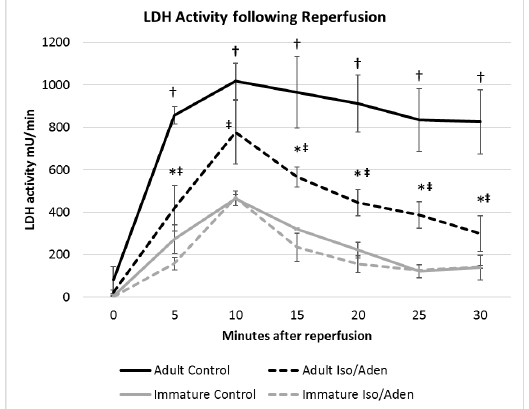
Figure 6. The effect of Iso/Aden on LDH release after ischemia/reperfusion. LDH activity vs. time after reperfusion commenced for intervention (Iso/Aden treatment) and control experiments in the adult and immature groups. Data normalized to the coronary flow rate during the collection of each fraction. There was no difference within the immature group whereas there was a significant decrease in LDH release in treated adult hearts. Time = 0 is from a pre-ischemia fraction. Data shown as Mean ± standard error. * = p < 0.05 vs. Adult Control. † = p < 0.05 vs. immature control, ‡ = p < 0.05 vs. immature hearts treated with isoproterenol/adenosine.